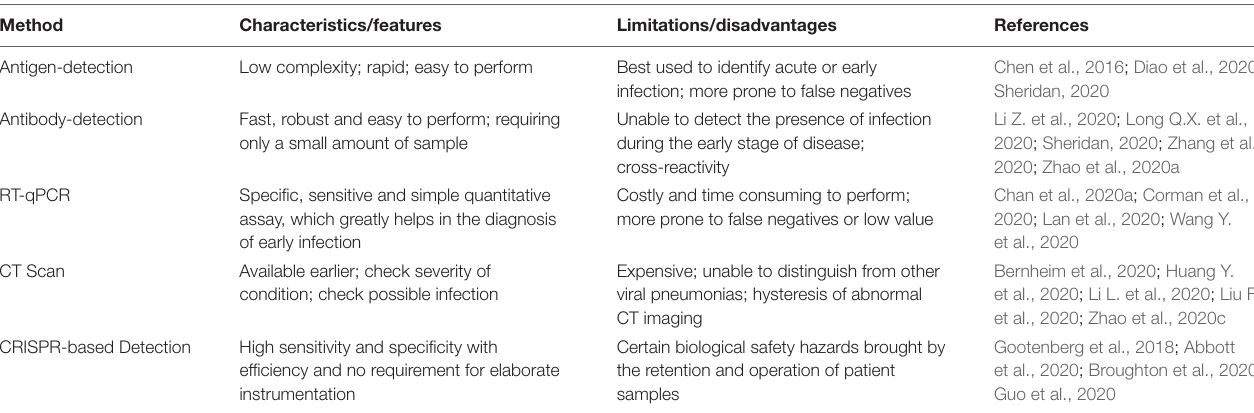
TABLE 1 | Different diagnostics methods for